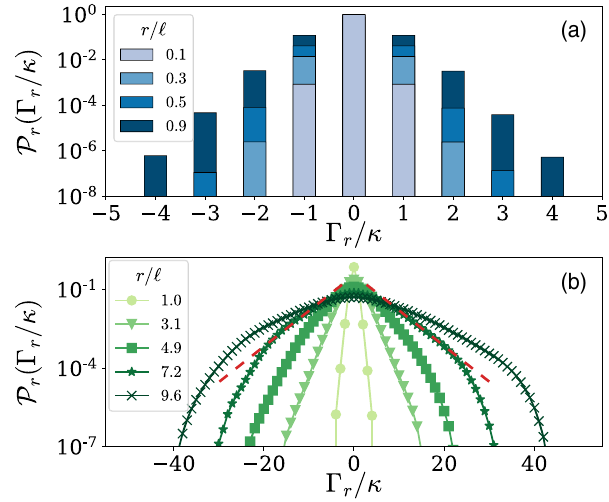
FIG. 3. PMF of the circulation in quantum turbulence for (a) loop sizes r= l < 1 and (b) loop sizes r= l ≥ 1 . The red dashed lines are a guide for the eye indicating exponential tails. Note that = κ only takes integer values. In all distributions are discrete, as Γ r 0 Þ and r= l ≥ 0 . 3 are hidden behind the panel (a), bars for P r ð 0 Þ r= l ¼ 0 . 1 case. See Fig. 6 for details on P r ð